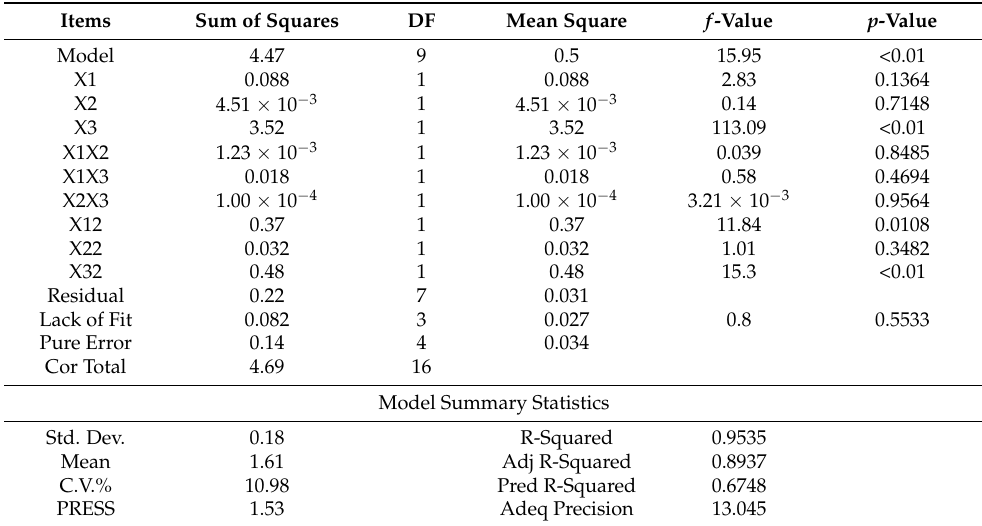
Table 4. The analysis of variance for detachment